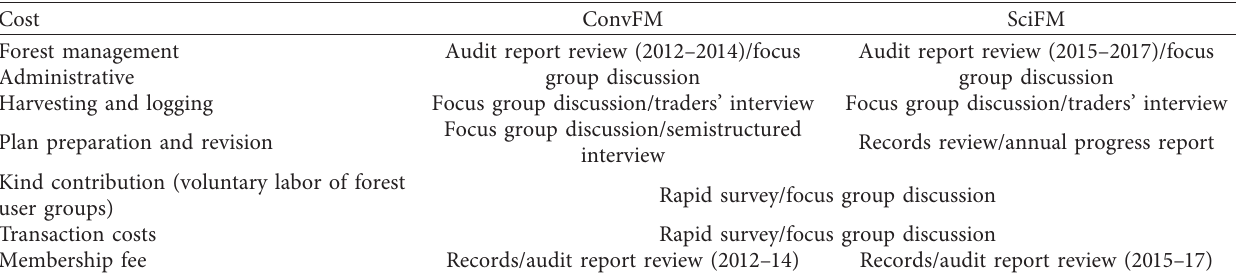
Table 4: Methods followed for the estimation of